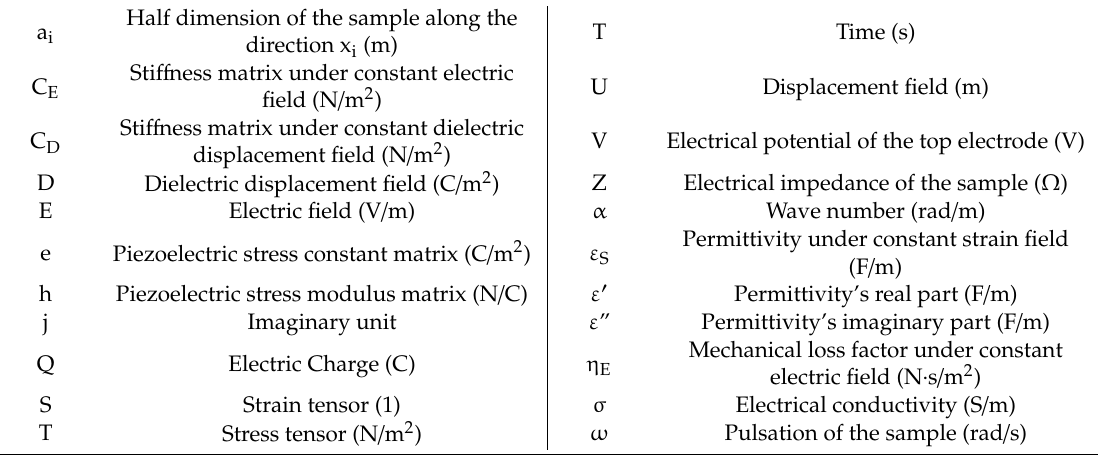
Table 1. Symbols used in the present article to describe the